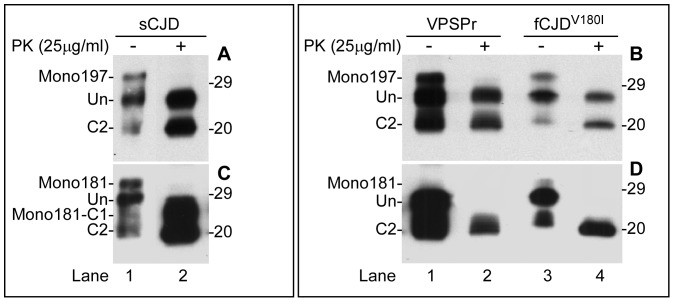
Detection of PrPSc before and after PK-treatment.PrP in P2 fractions from sCJD, VPSPr and fCJDV180I was subjected to g5p-capture and treatment with or without PK prior to Western blotting with Bar209 (A and B) or V14 (C and D).